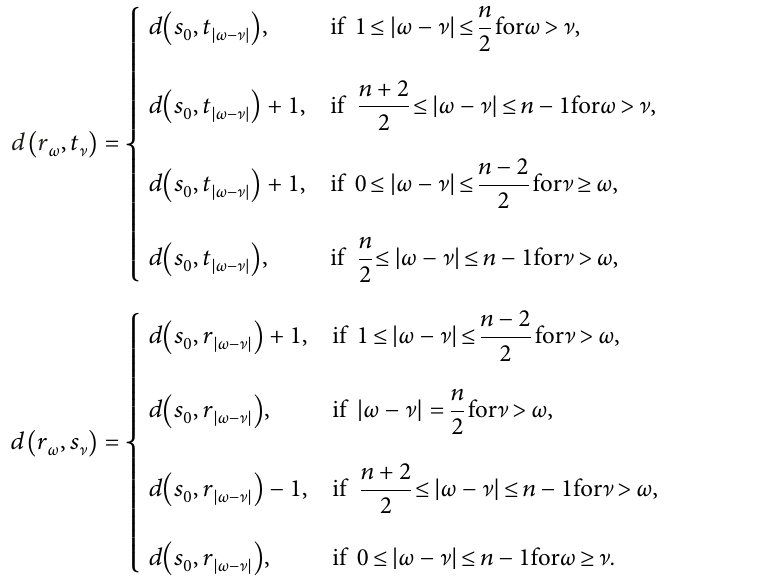
Table 2 shows that the representation r ( g , D ) − r ( g , D ) ≠ 0 for any two vertices T n T n 1 2